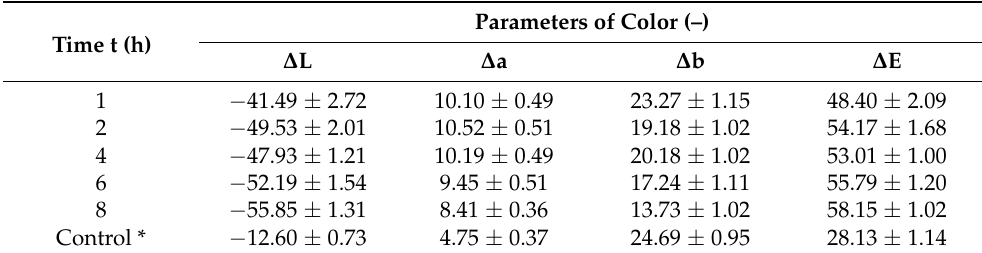
Table 1. Parameters of color change in heat-treated wood at different treatment time and at constant temperature.